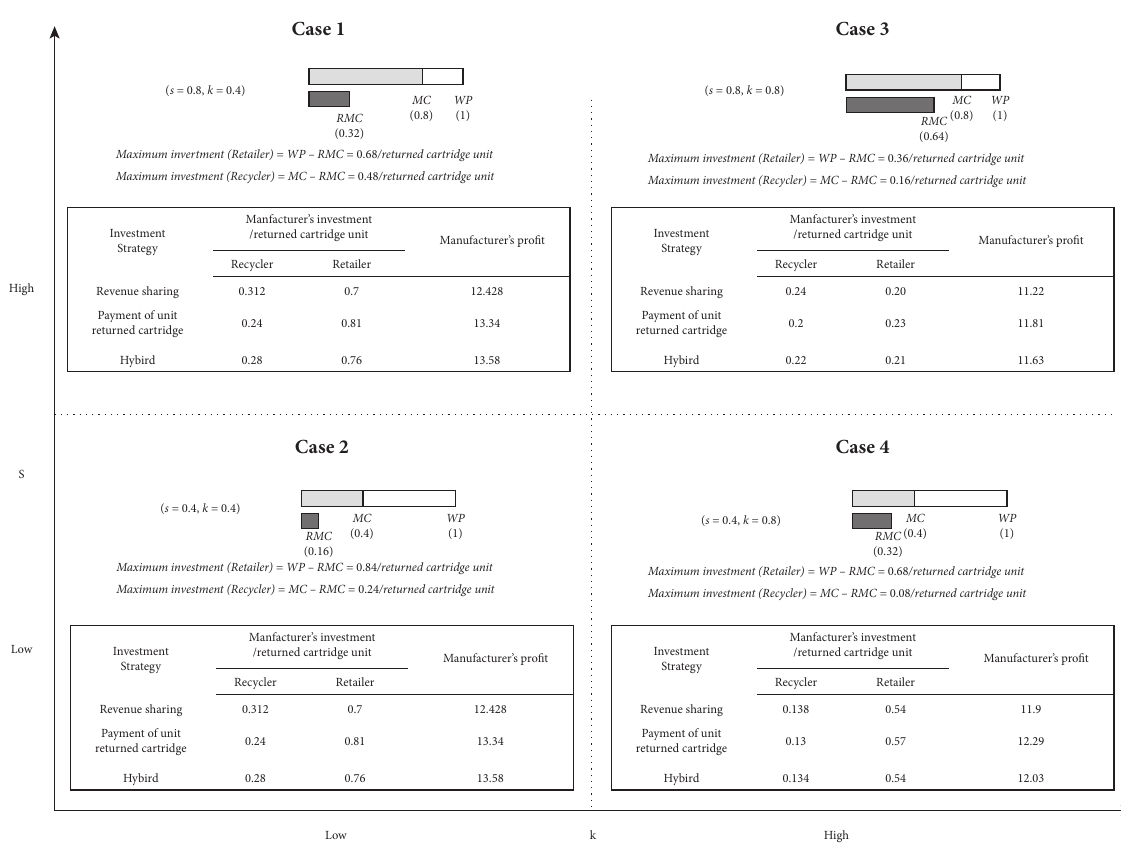
Figure 9: Sensitivity analysis with two